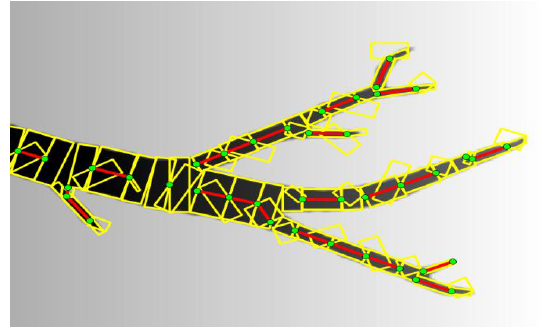
Figure 7. Results achieved by excluding the prior term penalising overlapping areas ( p o = 0).